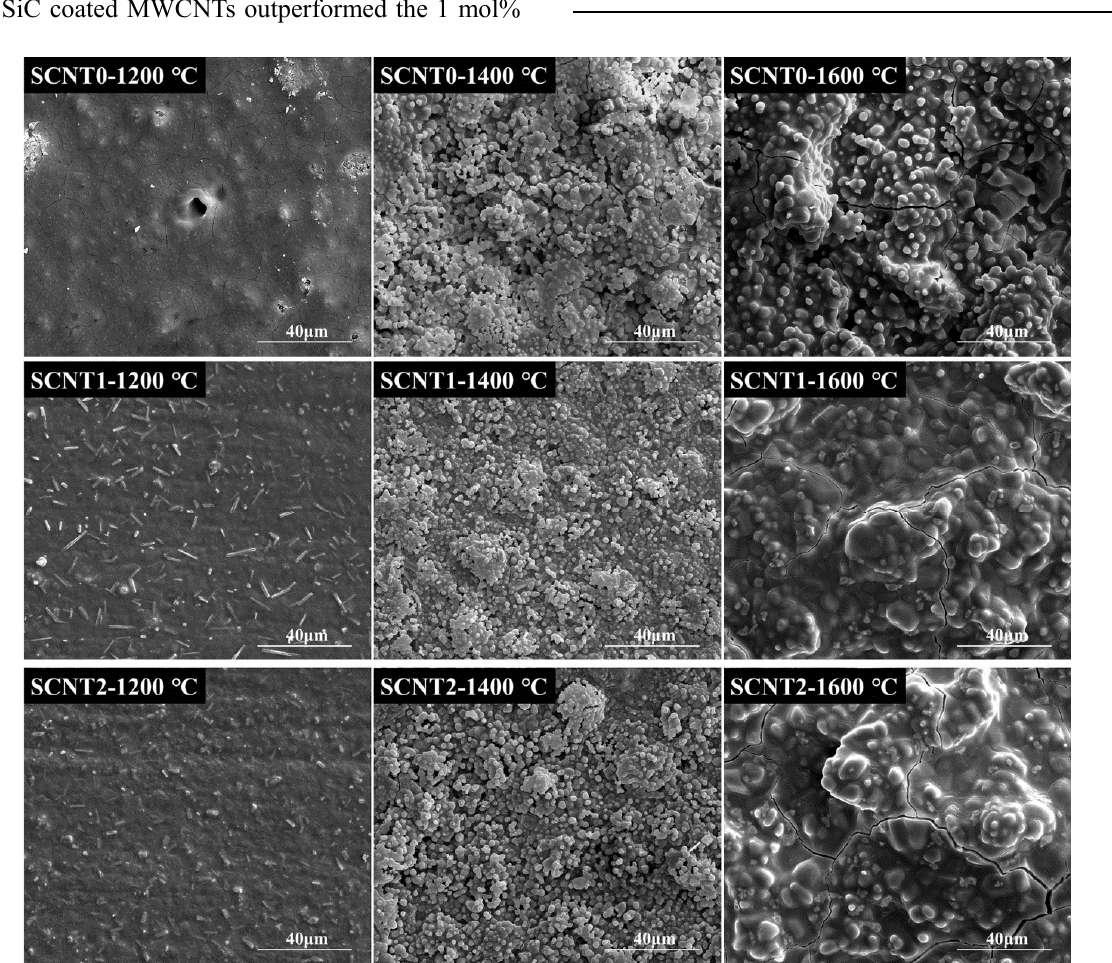
Fig. 9 SEM microstructures of Si 2 BC 3 N ceramics after oxidation